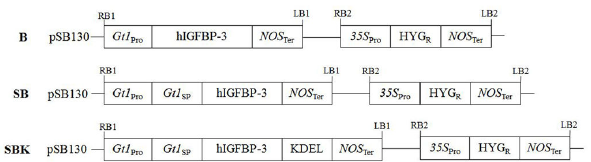
Figure 1. The rhIGFBP-3 expression constructs used for rice transformation. All constructs carrying the plant-codon optimized hIGFBP-3 were driven by glutelin 1 (Gt1) promoter. The construct, pSB130/Gt1/IGFBP-3 (B), contained modified